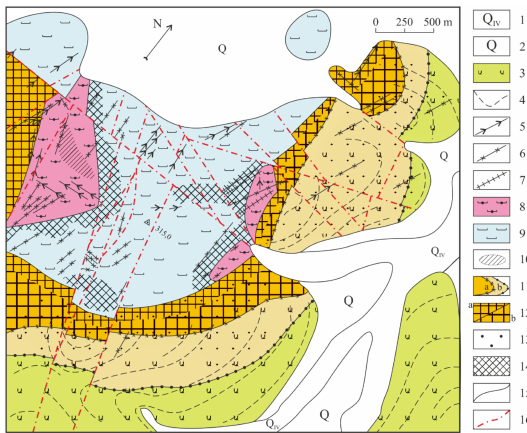
Figure 10. Map of the geological structure of the Kresty volcano–plutonic structure [1]: (1) recent al- luvial sediments; (2) Quaternary sediments; (3) effusive melanephelinite stratum; (4) melanephelinite clastic lavas; (5,6) dikes: (5) alkaline microsyenites, and (6) trachybasalts, trachidolerites, plagioclase porphyrites and picrites; (7) dikes (microsyenites, trachybasalts, alkaline picrites); (8) melilitolites, also skarned; (9) olivinites, wehrlites and pyroxenites; (10) monticellitolites; (11) facies of fenites and fenitized rocks: (a) perovskite-aegirine-augite (inner and intermediate zones); outer boundary of the facies—perovskite isograde; (b) titanite-biotite-aegirine-augite (outer zone of fenitized rocks); outer boundary—titanite isograde; (12) perovskite fenites: (a) uniformly fine-grained (inner zone), (b) blastoporphyry (intermediate zone); (13) biotite-containing fenitized rocks; (14) injected melilitolite- ultramafites, skarned and recrystallized rocks of the contact zone of melilitolite bodies; (15) geological boundaries; (16) assumed